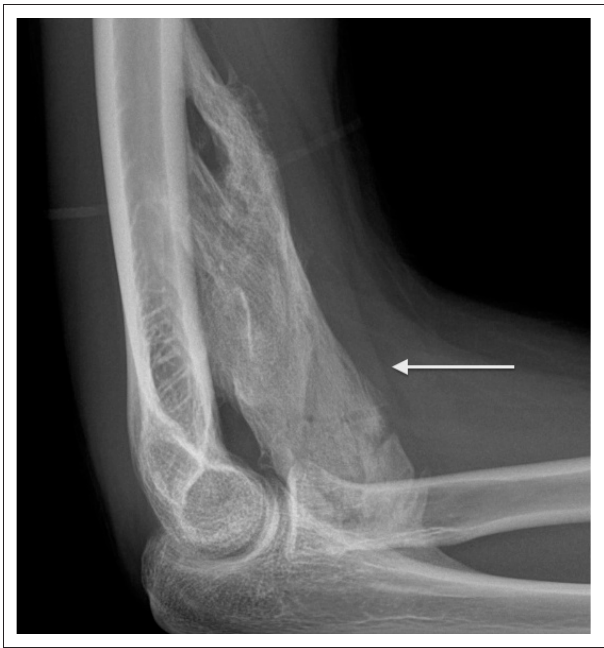
FIGURE 3: Lateral radiograph of the elbow demonstrates mature heterotopic soft-tissue bone formation (arrow).